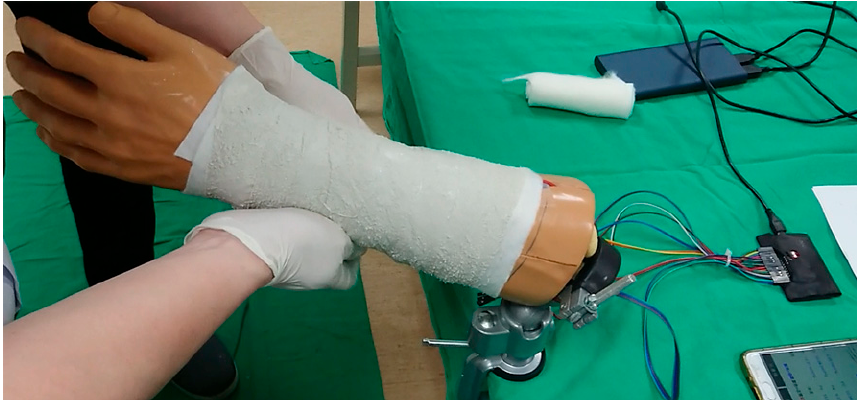
Figure 6. The participant applies a short arm plaster cast to the simulated arm.